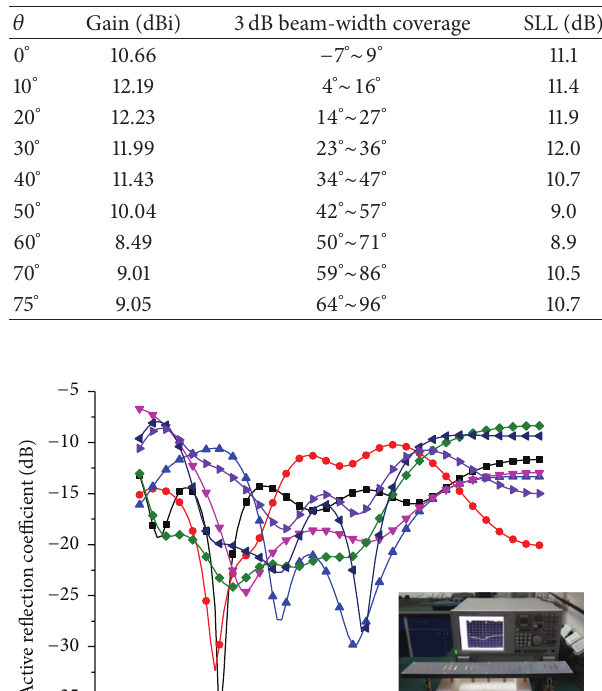
Table 3: Simulated scanning characteristics of the prototype.